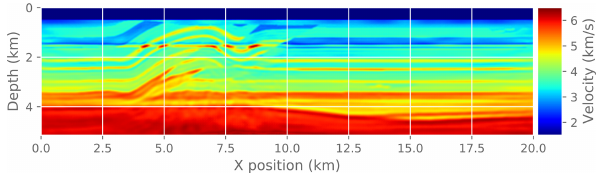
Figure 17. The final image after running FWI atol = 10 − 1 . It is visually indistinguishable from the reference solution in Fig. 15.